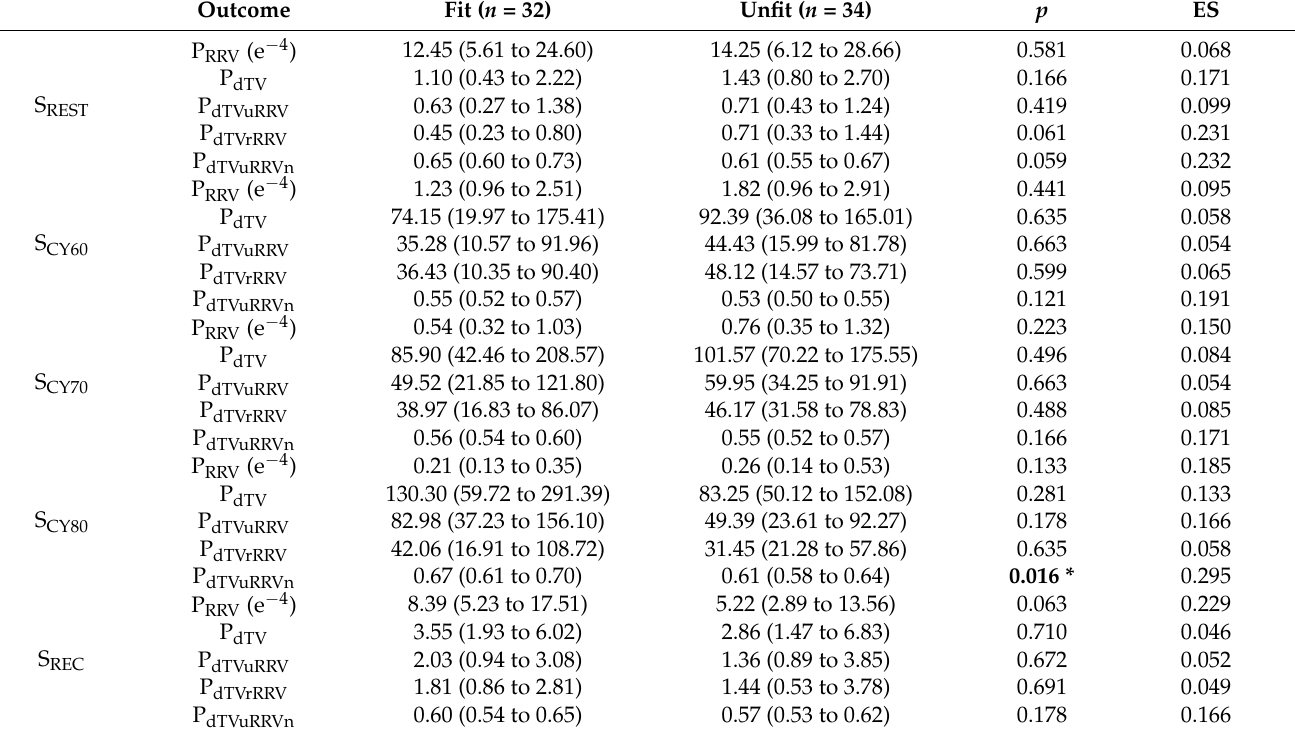
Table A3. Comparison of P RRV , P dTV , P dTVuRRV , P dTVrRRV and P dTVuRRVn between cardiorespiratory fitness level (PWC 80% )